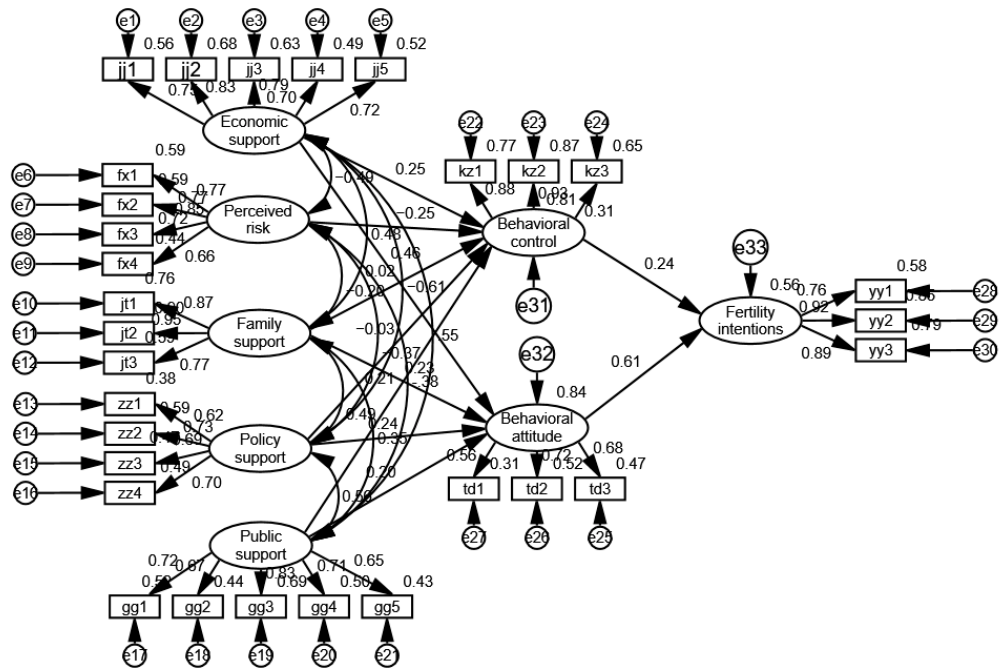
Figure 5. Standardized structural equation model diagram. Table 10. Results of the hypothesis test.